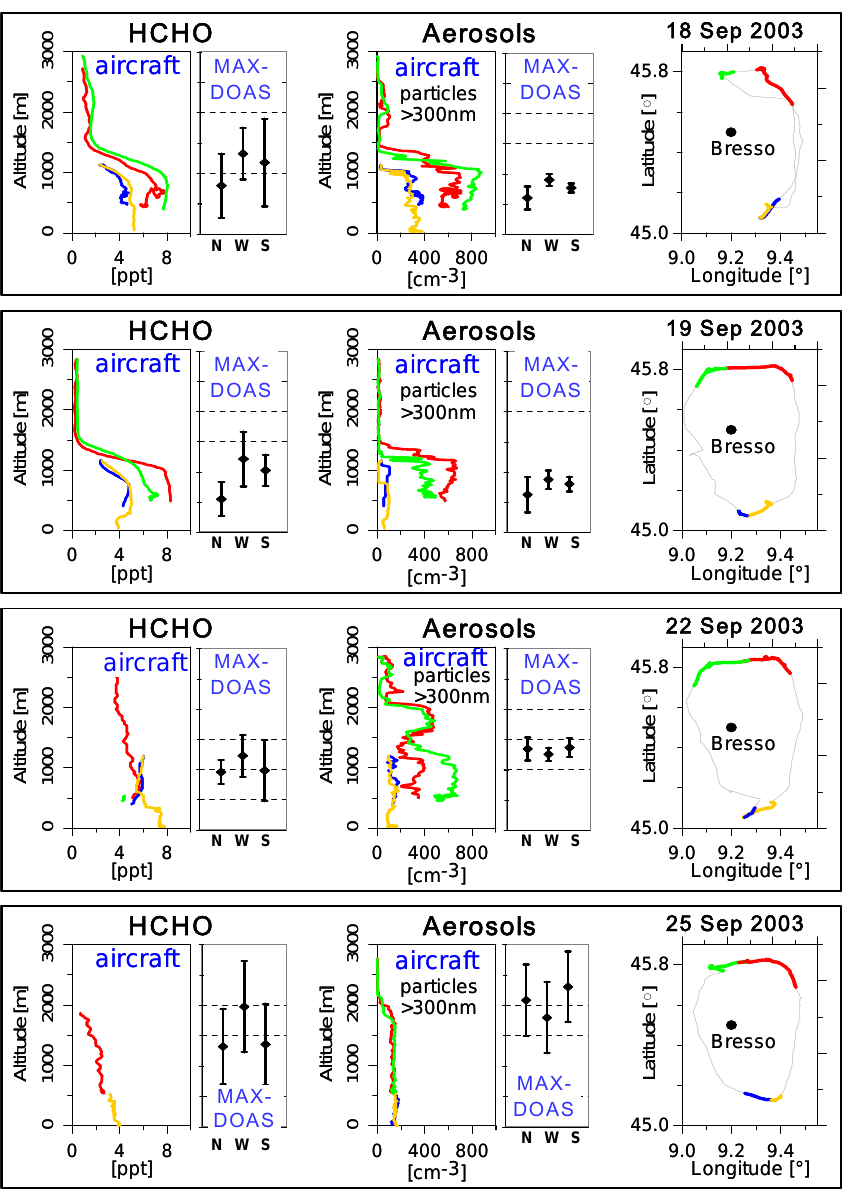
Fig. 17 Vertical profiles of the aerosol number density (for radii > 300nm) and HCHO mixing ratio measured by an ultra light aircraft. The respective flight tracks and the location of Bresso are indicated in the right part of the figure. Also shown are the layer heights retrieved from MAX-DOAS at Bresso during the period ( ± 30 min) of the aircraft measurements.